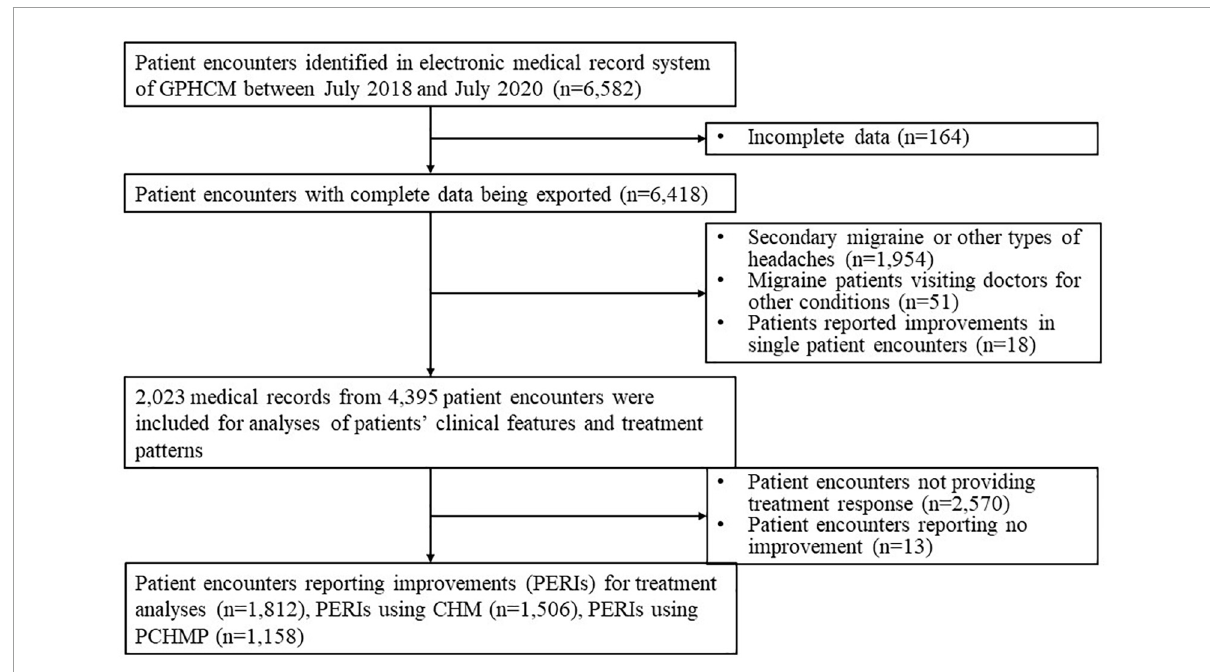
FIGURE1 Flow chart of the study procedure. CHM, Chinese herbal medicine; GPHCM, Guangdong Provincial Hospital of Chinese Medicine; PERI, Patient encounter reporting improvements; PCHMP, Patented Chinese herbal medicine products.